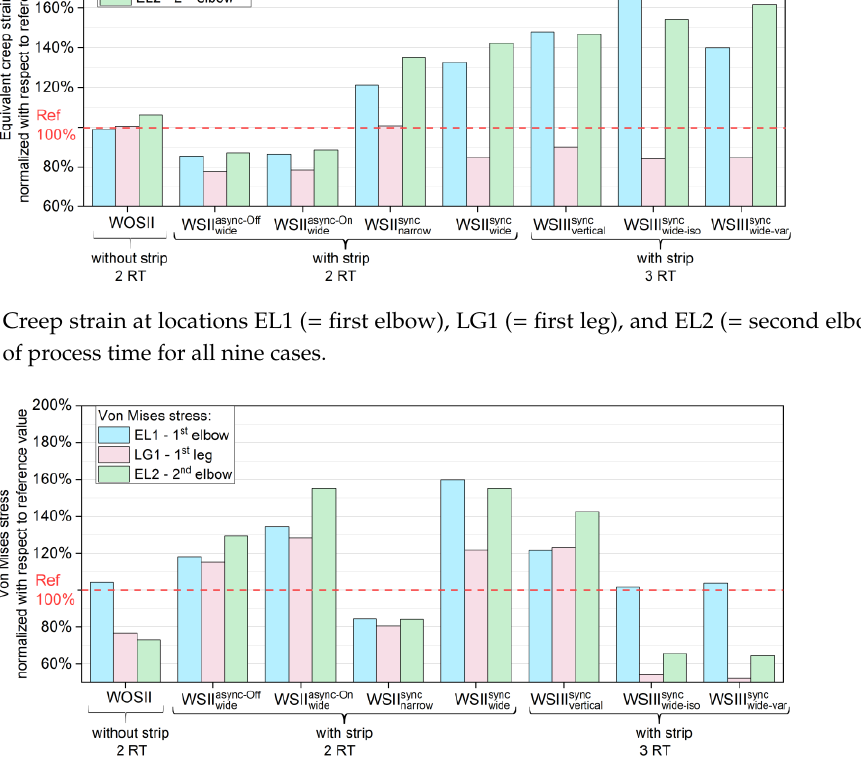
Figure 14. Von Mises stresses at locations EL1, LG1, and EL2 after 400 h of process time for all nine cases.